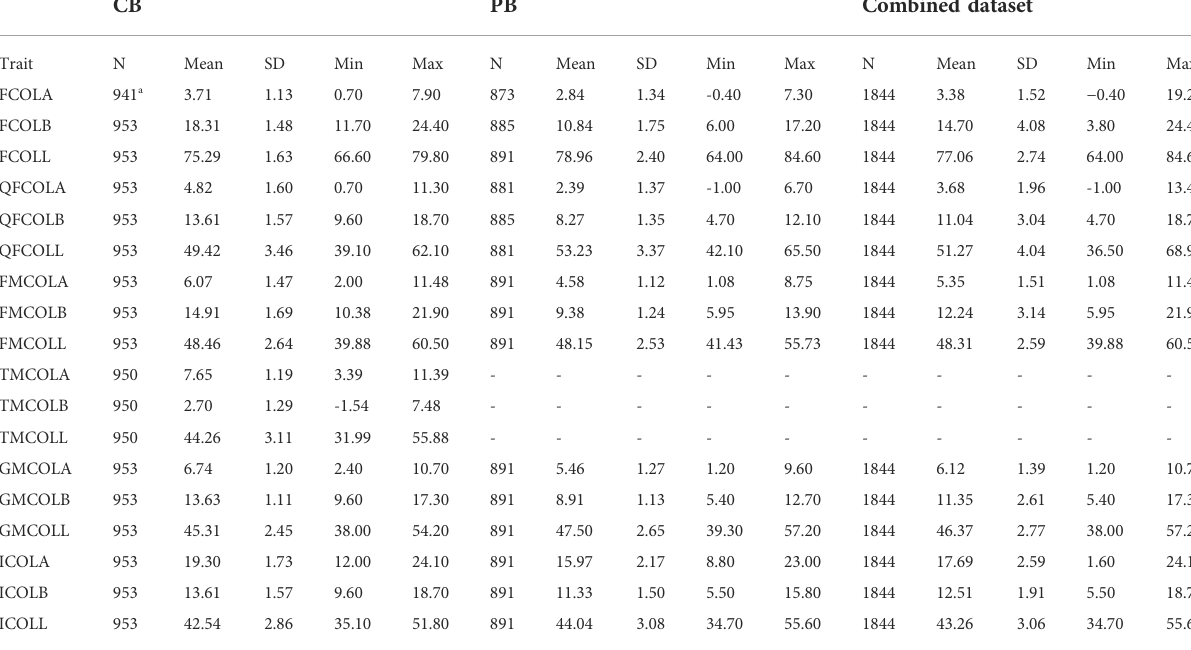
TABLE 2 Thedescriptive statistics for 18pork color traits: numberof animals pertrait(N),means,SD, minimum (Min.), andmaximum (Max.)values for different datasets (CB, PB, and Combined dataset). CB PB Combined